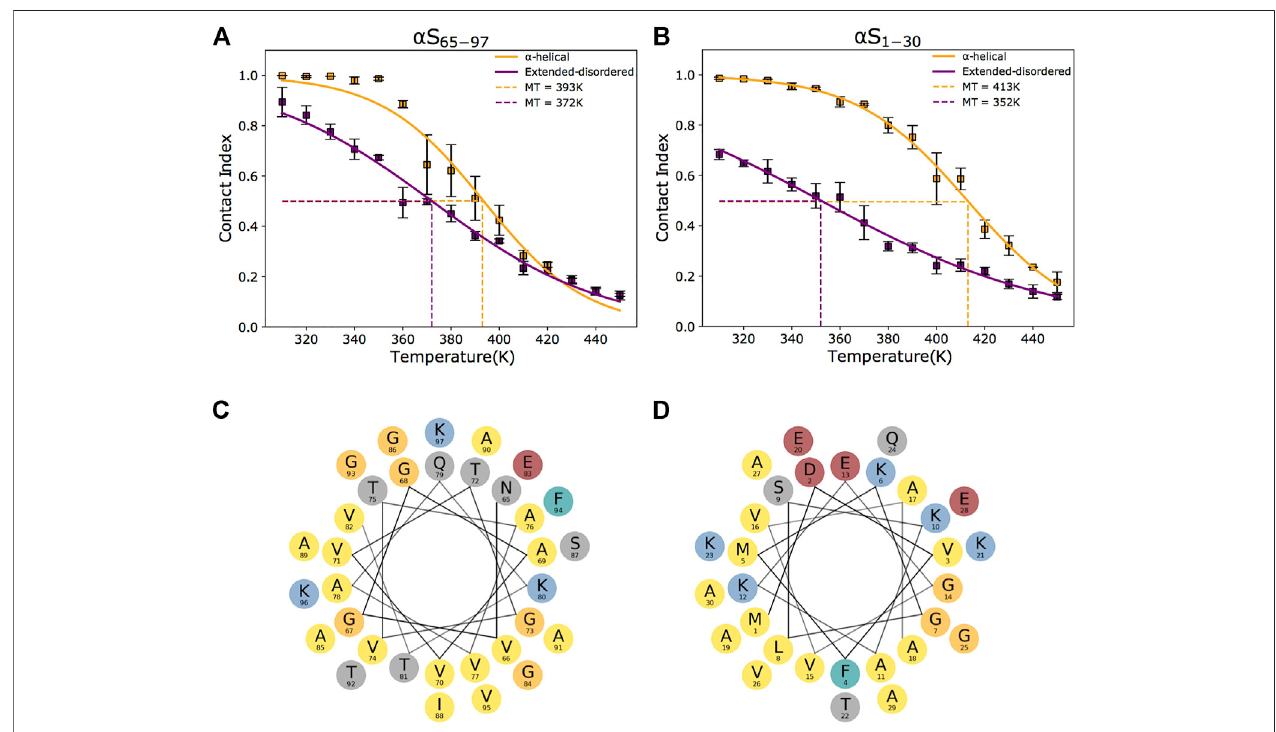
FIGURE 2 | Conformational dependencies in membrane binding. (A – B) Melting curves of membrane binding based on the global contact index plotted as a function of the simulation temperatures. Purple and yellow lines report the melting curves calculated with the protein in helical and extended-disordered conformations, respectively. Binding curves to DOPE:DOPS:DOPC lipid bilayers by α S 65 – 97 and α S 1 – 30 are shown in panels (A) and (B) , respectively. Error bars report the standard deviation between three segments of the simulation. Data for α S 1 – 30 are reproduced from Navarro-Paya et al. (2020). The difference in the melting temperatures in helical and extended-disordered conformations is attenuated in the case of α S 65 – 97 compared to α S 65 – 97 . (C – D) Helical projections of the α S sequence reveal the amphipathic nature of α S